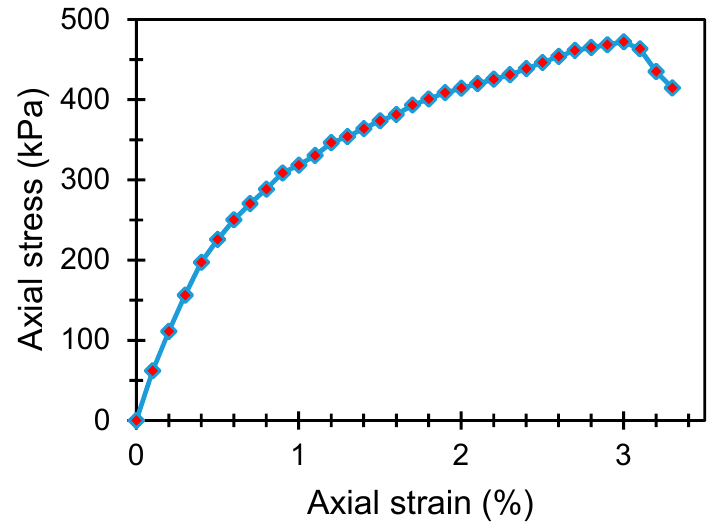
Figure 4. Axial stress–strain relation.